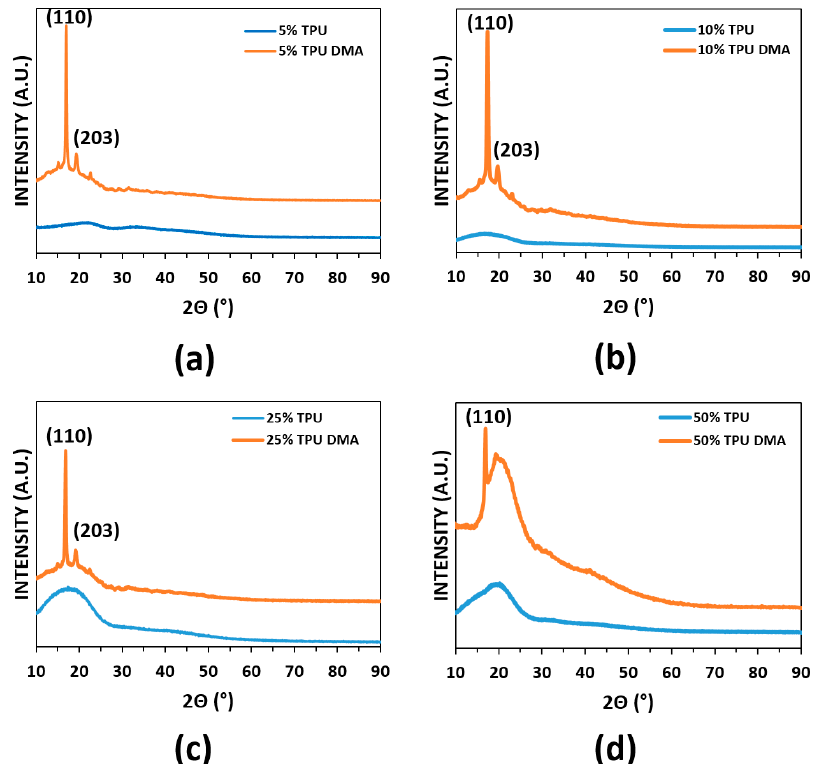
Figure 8. XRD spectra of the PLA:TPU blend combination before and after DMA testing where ( a – d ) correspond to 5, 10, 25, and 50% by weight TPU, respectively.